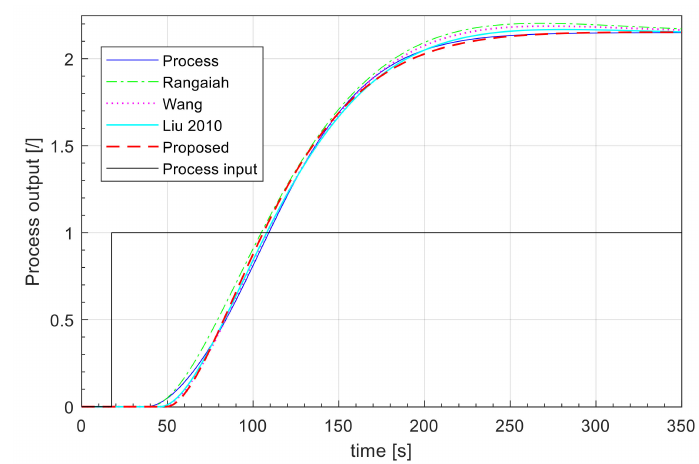
Figure 16. The step-change responses for process G P4 .